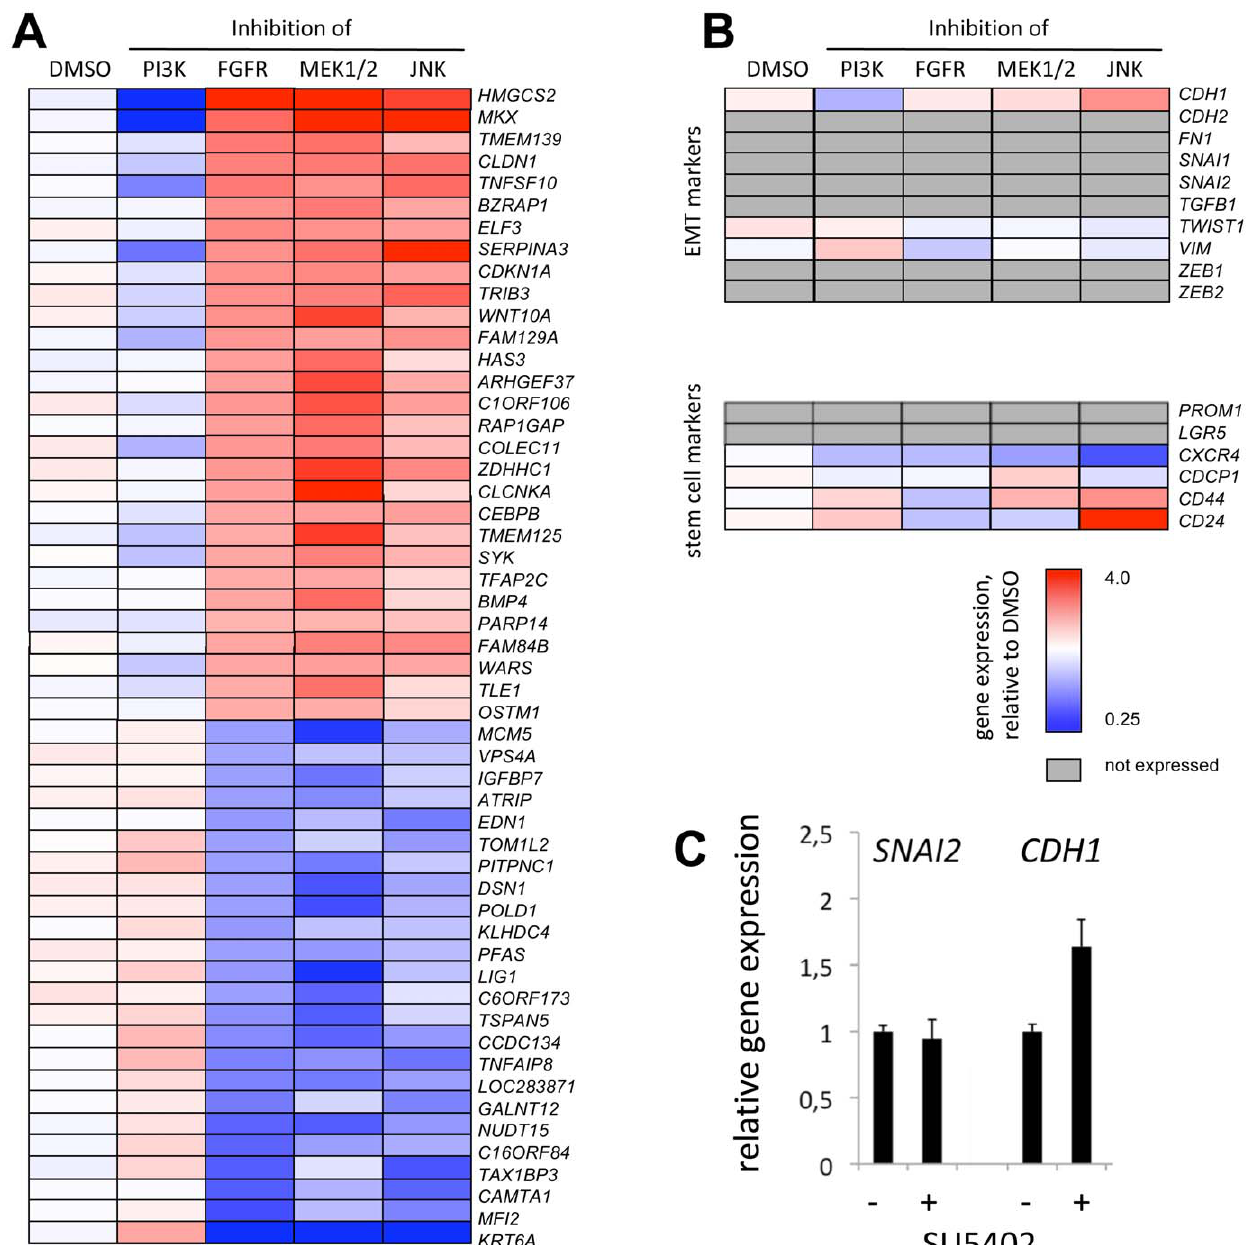
Figure 5. Epithelial and mesenchymal phenotypes of SW480 cells correlate with gene expression signatures. A–B Microarray analysis of SW480 after small molecular inhibition of FGFR, MEK1/2, JNK or PI3K. Average expression of triplicate experiments is displayed. Red: High expression; Blue: low expression White: Median expression across all profiles Grey: Genes with no or marginal expression A Clusters of genes whose activity correlates with epithelial and mesenchymal phenotypes. The following procedure was used to identify these genes: First, genes deregulated more than 1.3fold (p , 0.01) after SU5402 treatment compared to control (DMSO) were isolated. Second, these genes were clustered in self-organizing maps, and three clusters that correlated with the phenotype were selected. Genes were ordered by fold-change expression after FGFR inhibition. B Assessment of key genes implicated in EMT or stemness. C Quantitative Real-time PCR analysis of SNAI2 and CDH1 after SU5402 (FGFR Inhibitor) treatment. Expression was normalized to solvent control